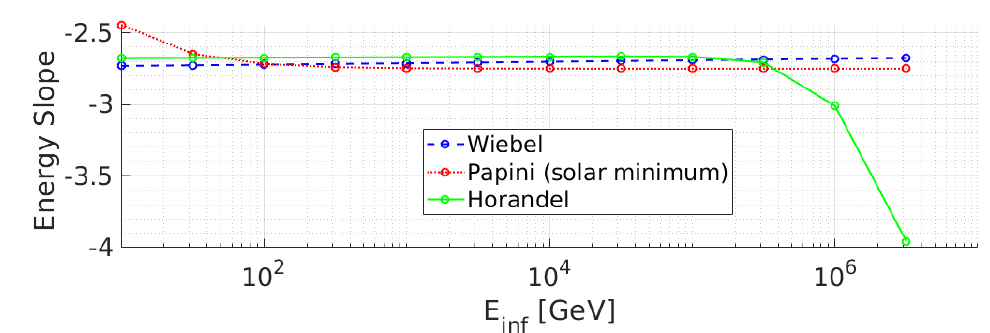
Figure 2. Slope coefficients of the primary spectra calculated with the [34,45,46] models as a function of the minimum value of energy range chosen in each simulation.